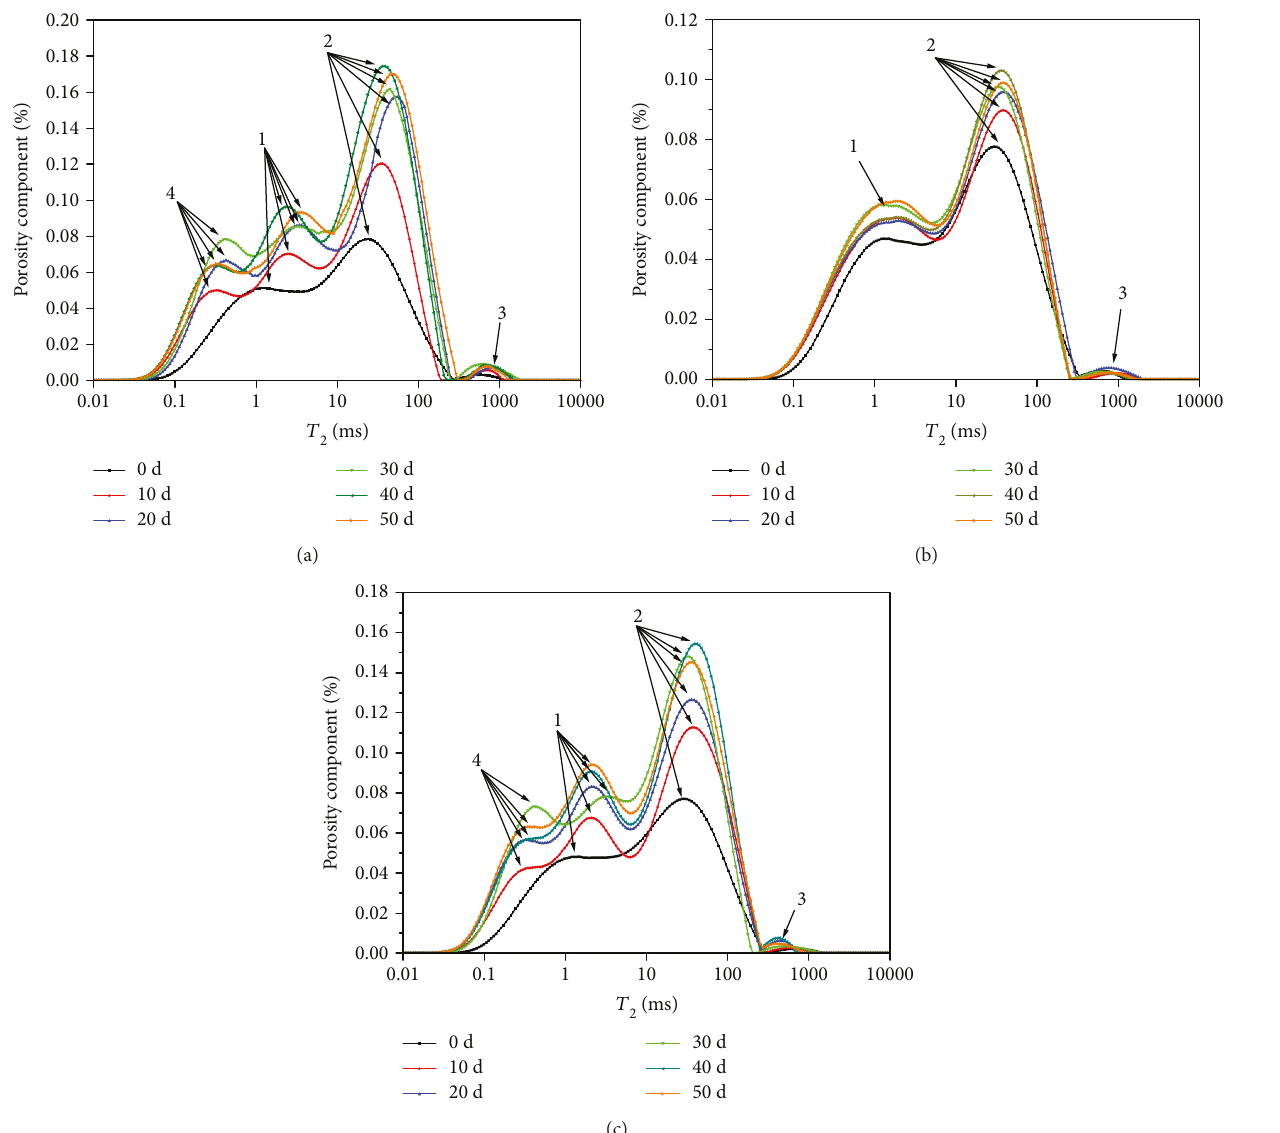
Figure 5: T distribution of specimens with di ff erent treatment types of chemical corrosion: (a) H 2 NaOH